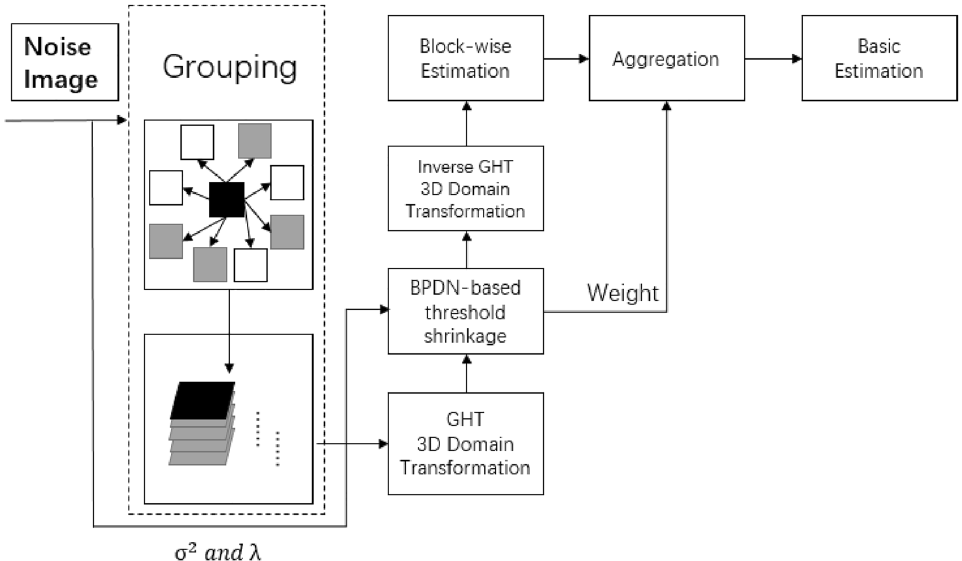
Figure 4. Flow chart of the proposed block-matching domain transformation